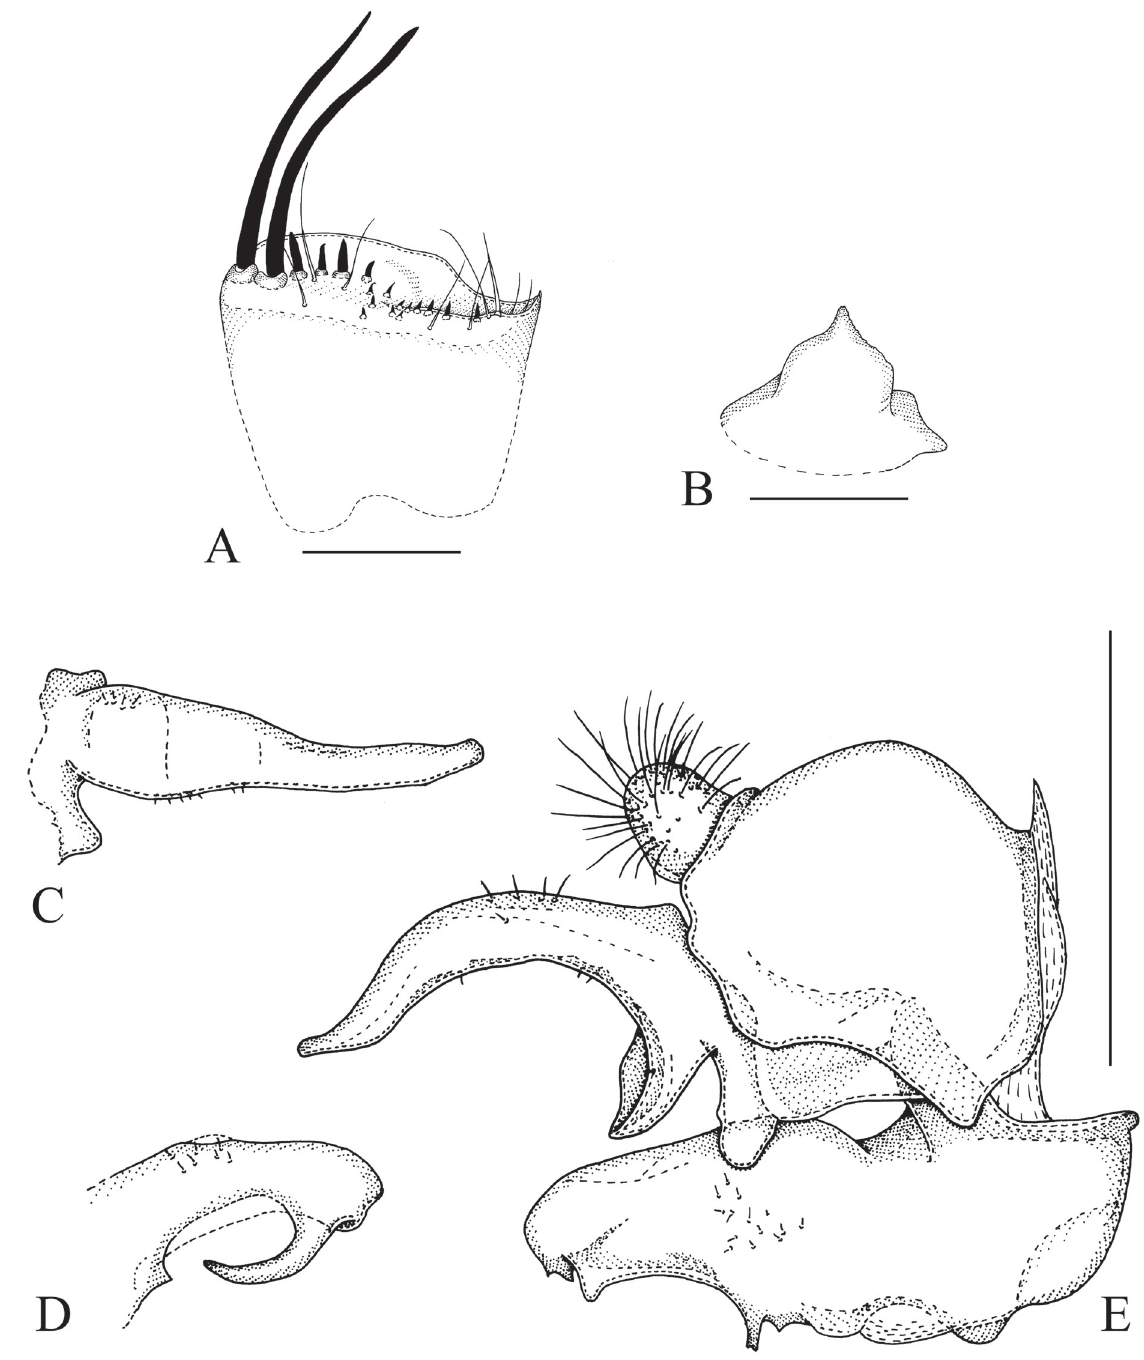
Fig. 17. Sphegina (Asiosphegina) bracon sp. nov., pa ratype, ♂ . A . Sternum IV, ventral view. B . Sternum VII, ventral view. C . Left surstylus, lateral view. D . Left superior lobe, lateral view. E . Genitalia, right side, lateral view. Scale bars = 0.5